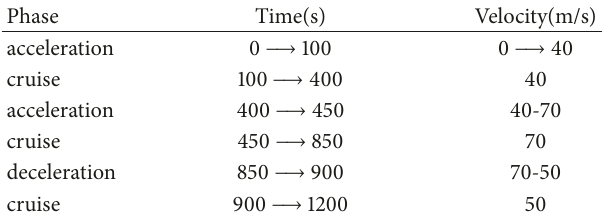
Table 2: Speed Command of high-speed